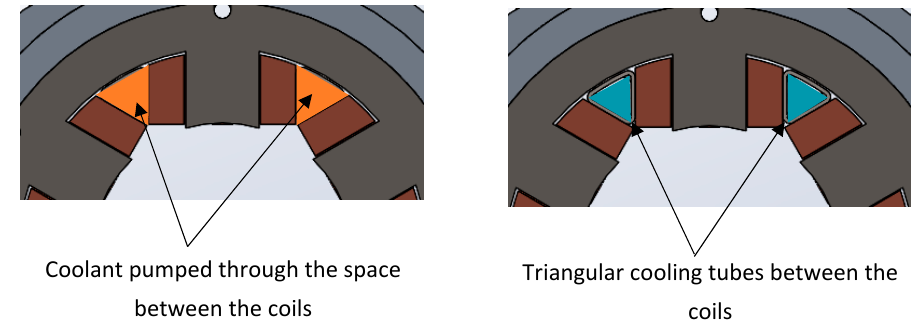
Figure 2. Two configurations of the direct coil cooling technique studied in the paper: DCC1 ( left ) and DCC2 ( right ).